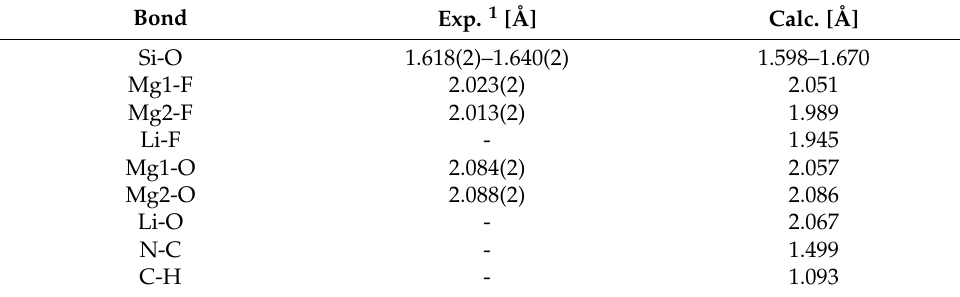
Table 4. Selected bond lengths for the L model of TMA-H.